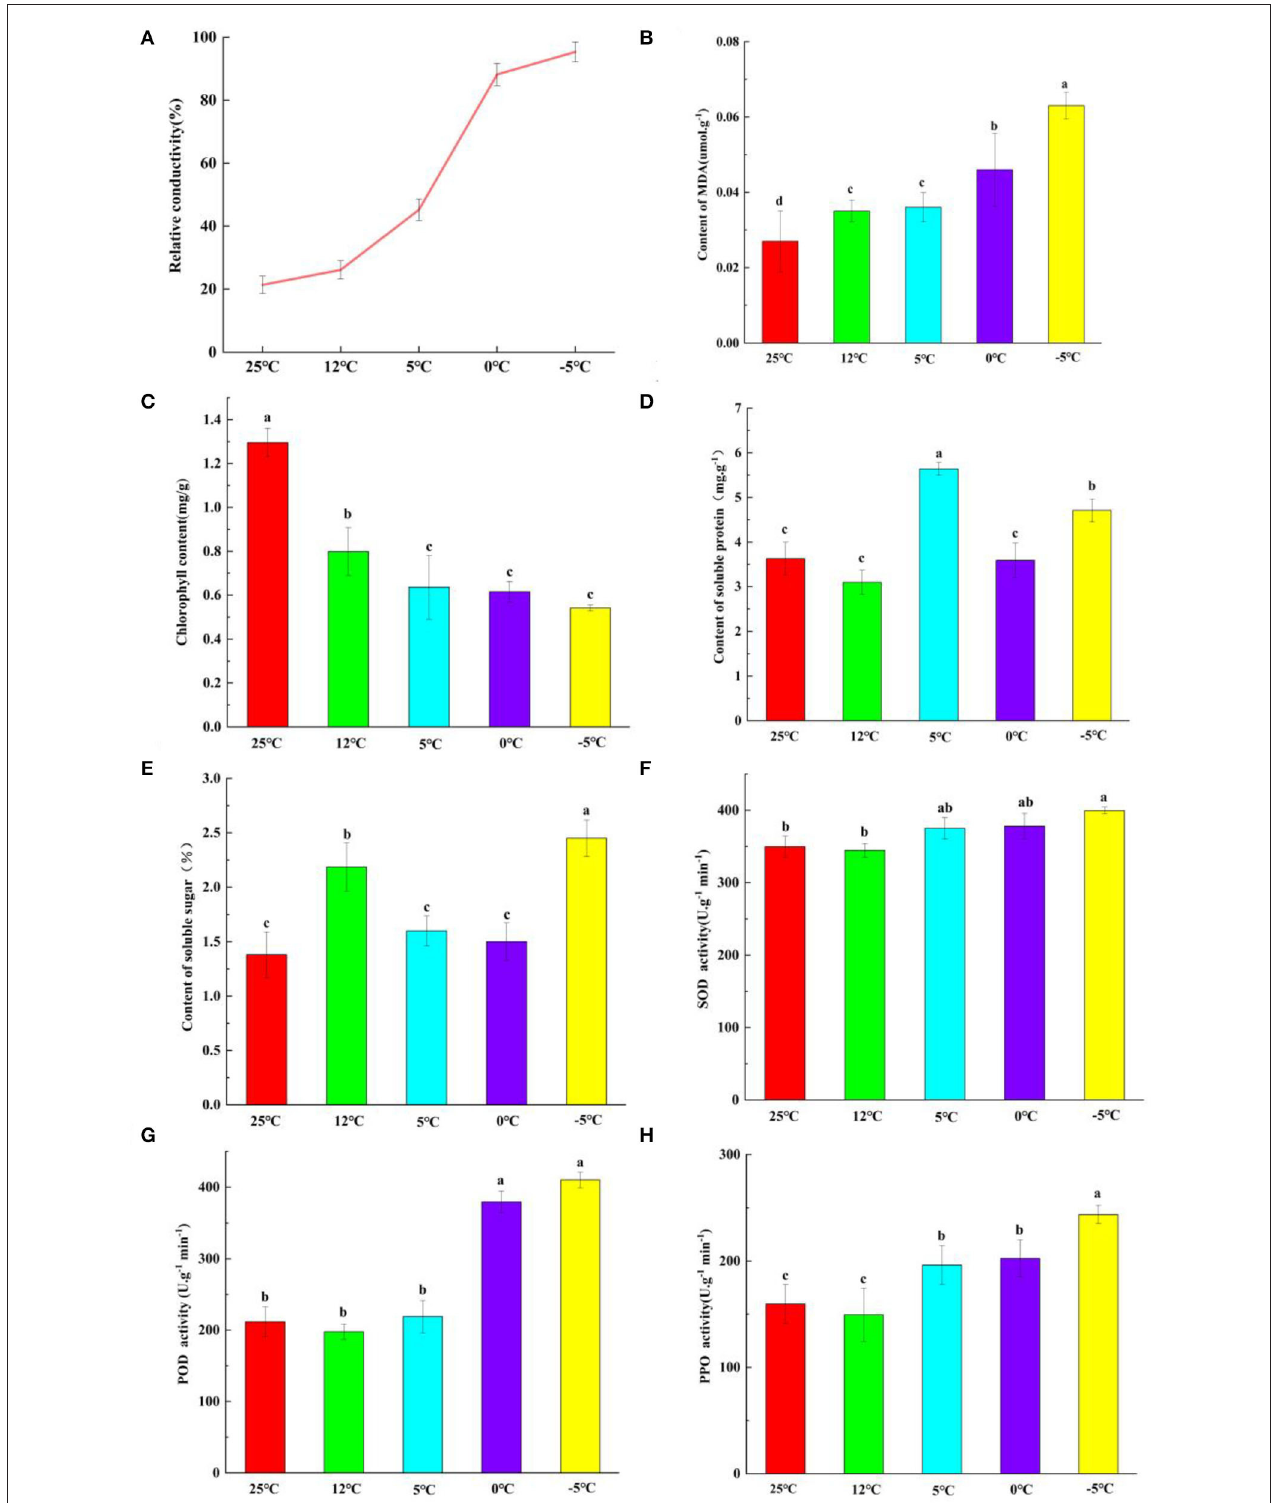
FIGURE 1 | Comparison of physiological indexes of M. microcarpa leaves treated by five temperature treatments. (A–H) The relative electric conductivity, MDA content, chlorophyll content, soluble protein content, soluble sugar content, SOD, POD, and PPO activities were compared under five temperature treatments of M. microcarpa leaves, respectively. All data were shown as mean ± SE ( n = 3). Within each treatment, means with different letters were significantly different at p < 0.05.